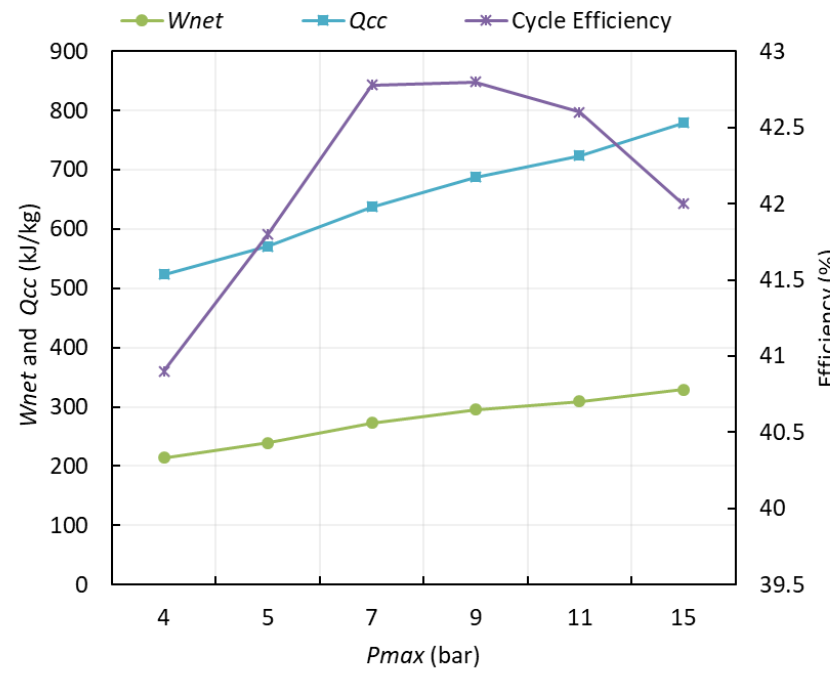
Figure 15. Variation of different parameters with the maximum pressure.